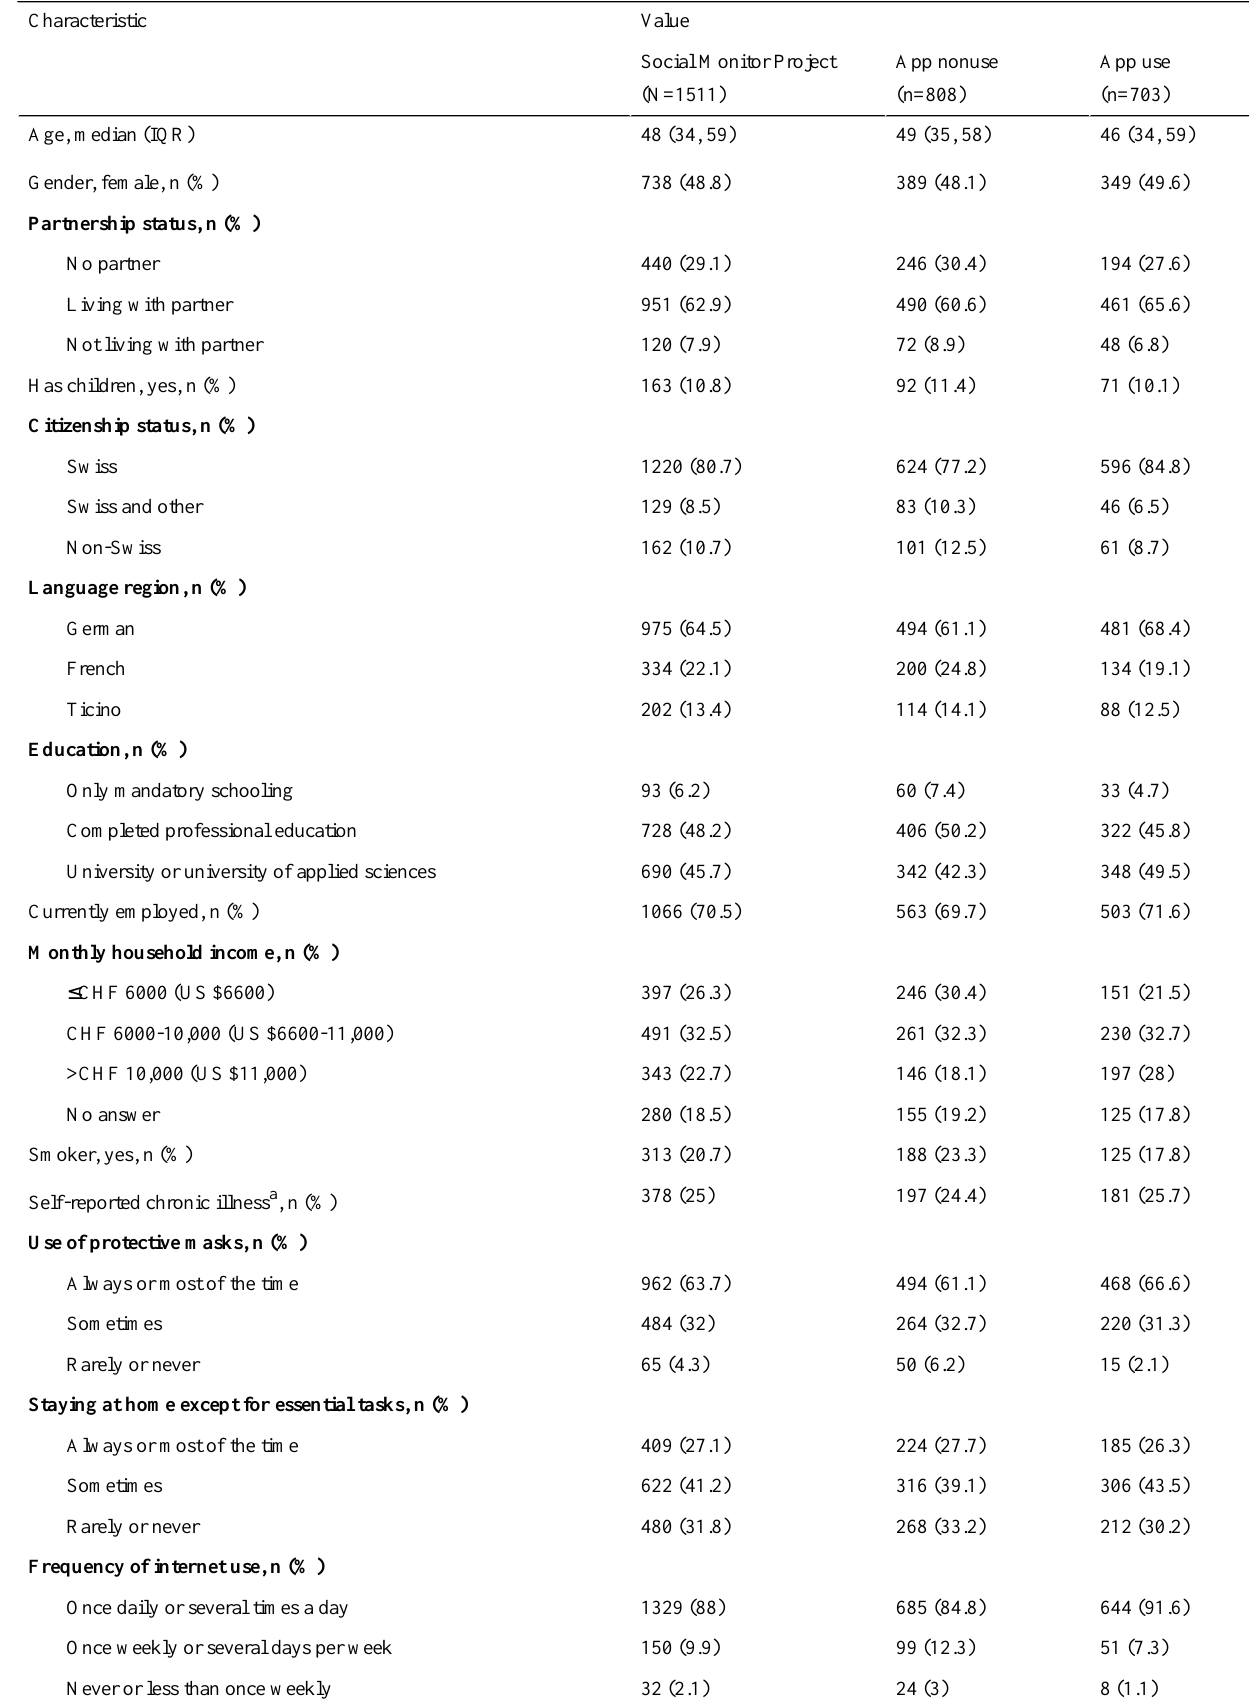
Table 1. Study populations of users and nonusers of the SwissCovid app, deployed in Switzerland as a mitigation measure for the COVID-19 pandemic.